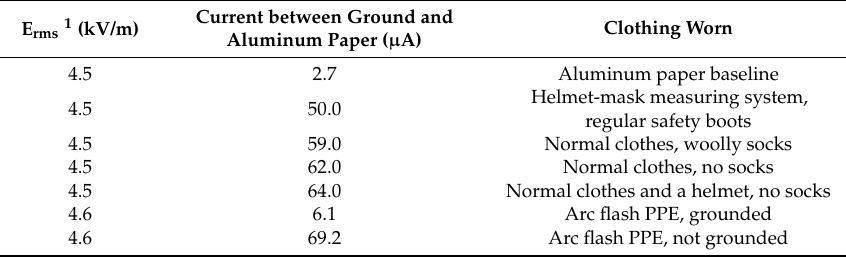
Table 1. Measured electric field strengths (kV/m) and current between the ground and the aluminum paper ( μ A) with a helmet-mask measuring system or different clothes.